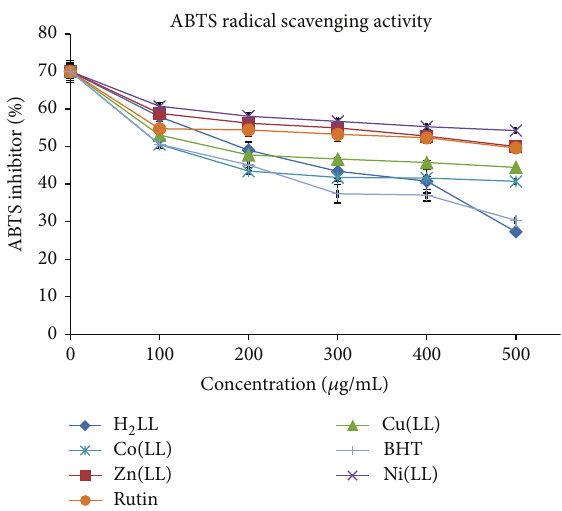
Figure 6: ABTS radical scavenger activity of H 2 LL and H 2 LL-M(II)